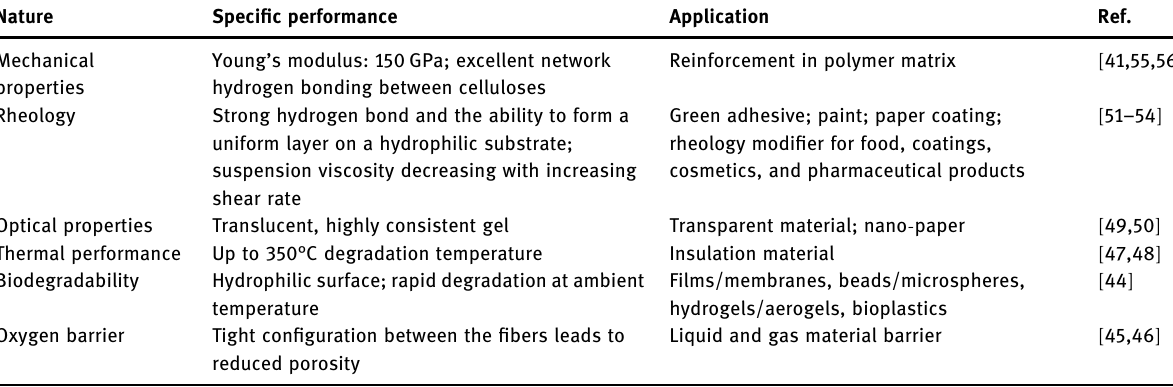
Table 1: Properties of NC